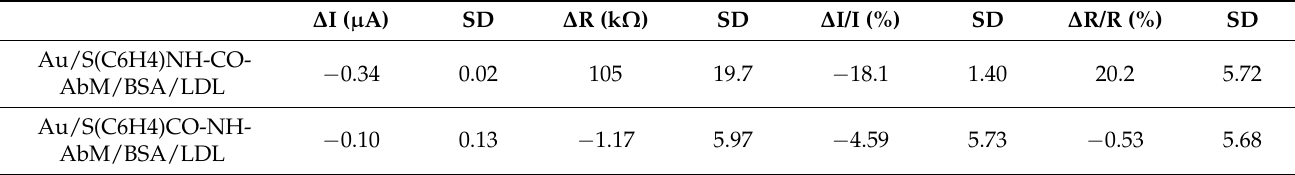
Table 1. The values of changes in current ( ∆ I, ∆ I/I) and changes in resistance ( ∆ R, ∆ R/R) registered for electrodes modified with AbM-anti-apoB antibody and 4-ATP linker (Au/S(C 6 H 4 )NH-CO-AbM-anti-apoB/BSA) or 4-MBA